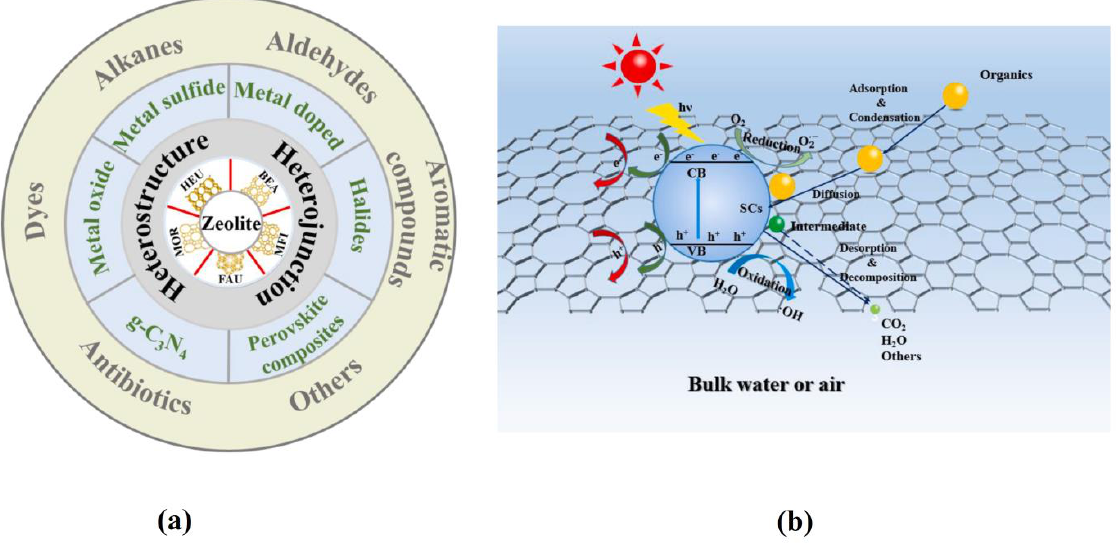
Figure 6. ( a ) Applications of zeolite-composite in the degradation of different organic contaminants in wastewater and air; ( b ) schematic of adsorption and photo-catalytic degradation on the surface of zeolite-based composites (Reprinted with permission from [129]).